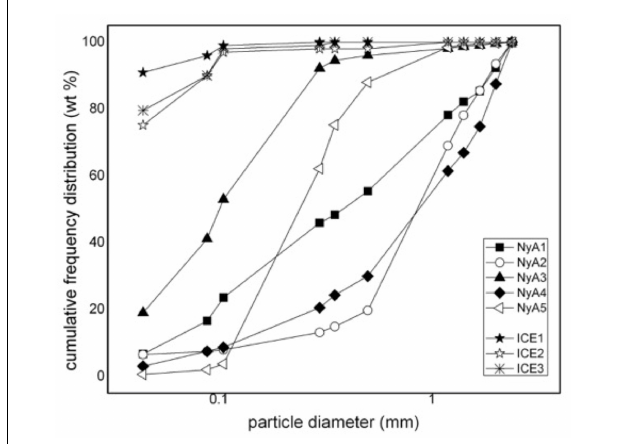
FIGURE 2 | Particle size distribution curves for the sediment samples from Ny-Alesund (NyA) and Iceland